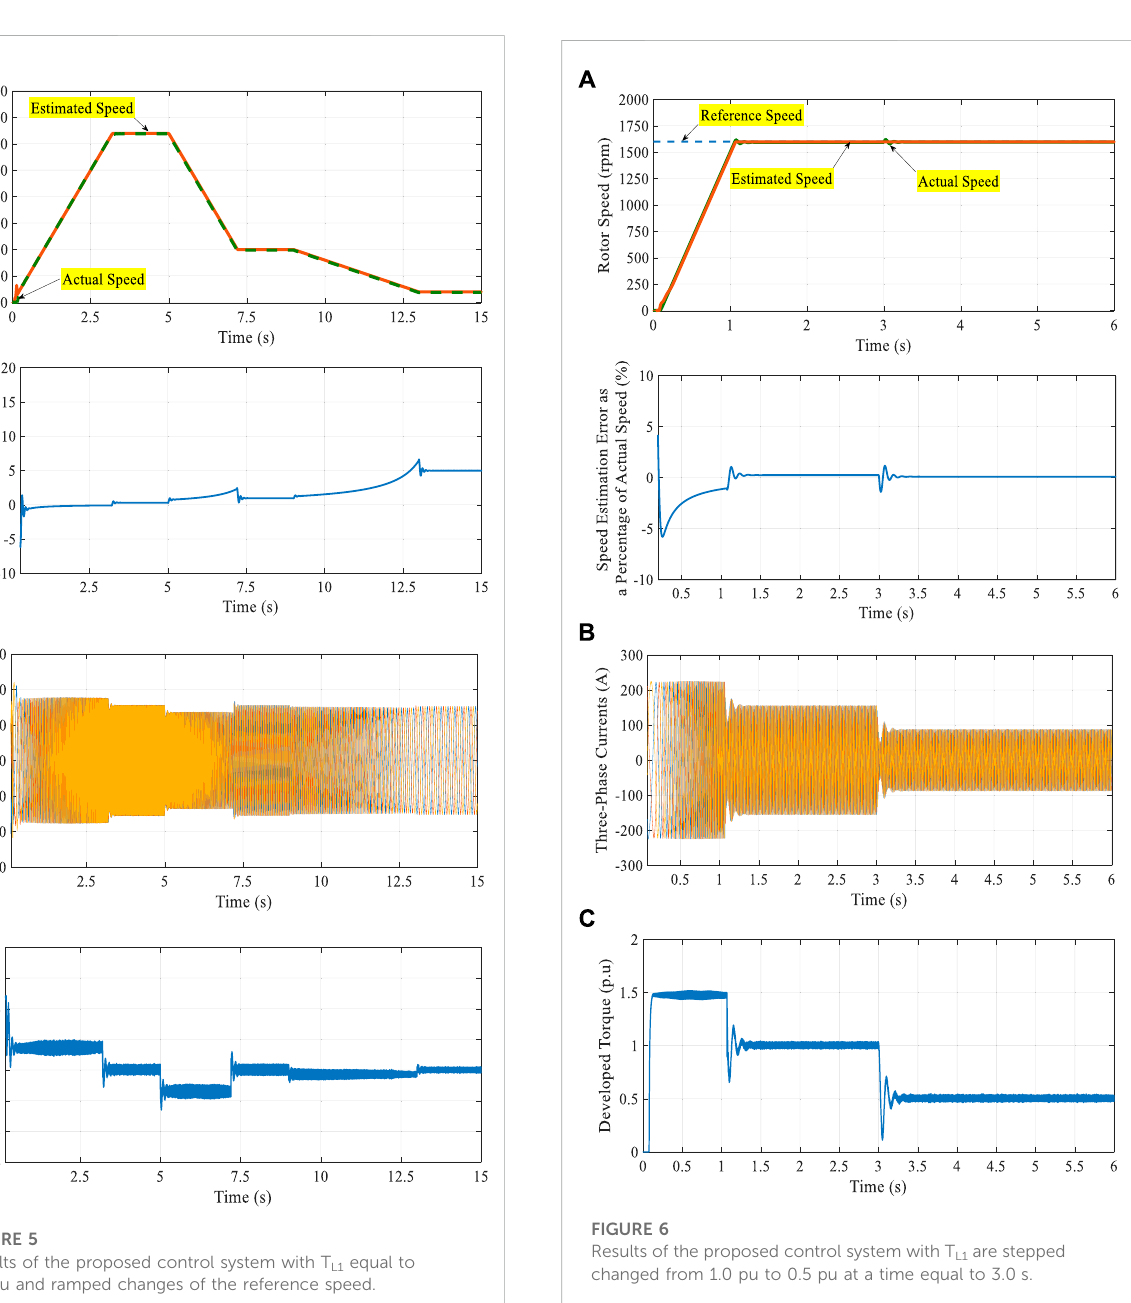
The results with T L1 equal to 1.0 pu and ramped changes of the reference speed are shown in Figure 5 including the operation under the low-speed region. As shown in Figure 5A, the speed is changed from 1,600 rpm (high- speed region) to 500 rpm and then followed by a ramp change from 500 rpm to 100 rpm (low-speed region). The reference speed is tracked, and the validity of the suggested speed estimation methodology is con fi rmed as shown in Figure 5A. The corresponding current and torque are shown Figures 5B,C,respectively.